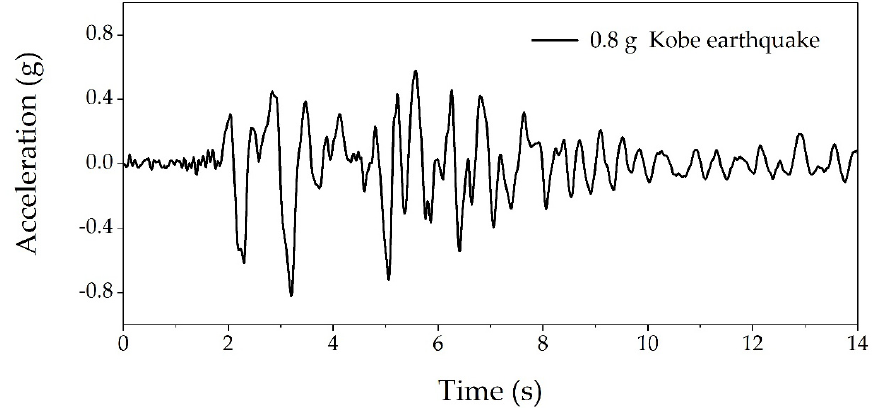
Figure 10. The validated 1995 Kobe earthquake (north–south component) employed in the dynamic